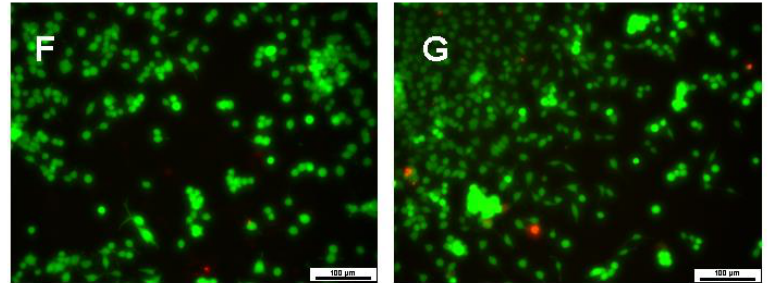
Figure 9. LIVE/DEAD images of PC12 cells 7 days in culture after treatment with nanocapsules.